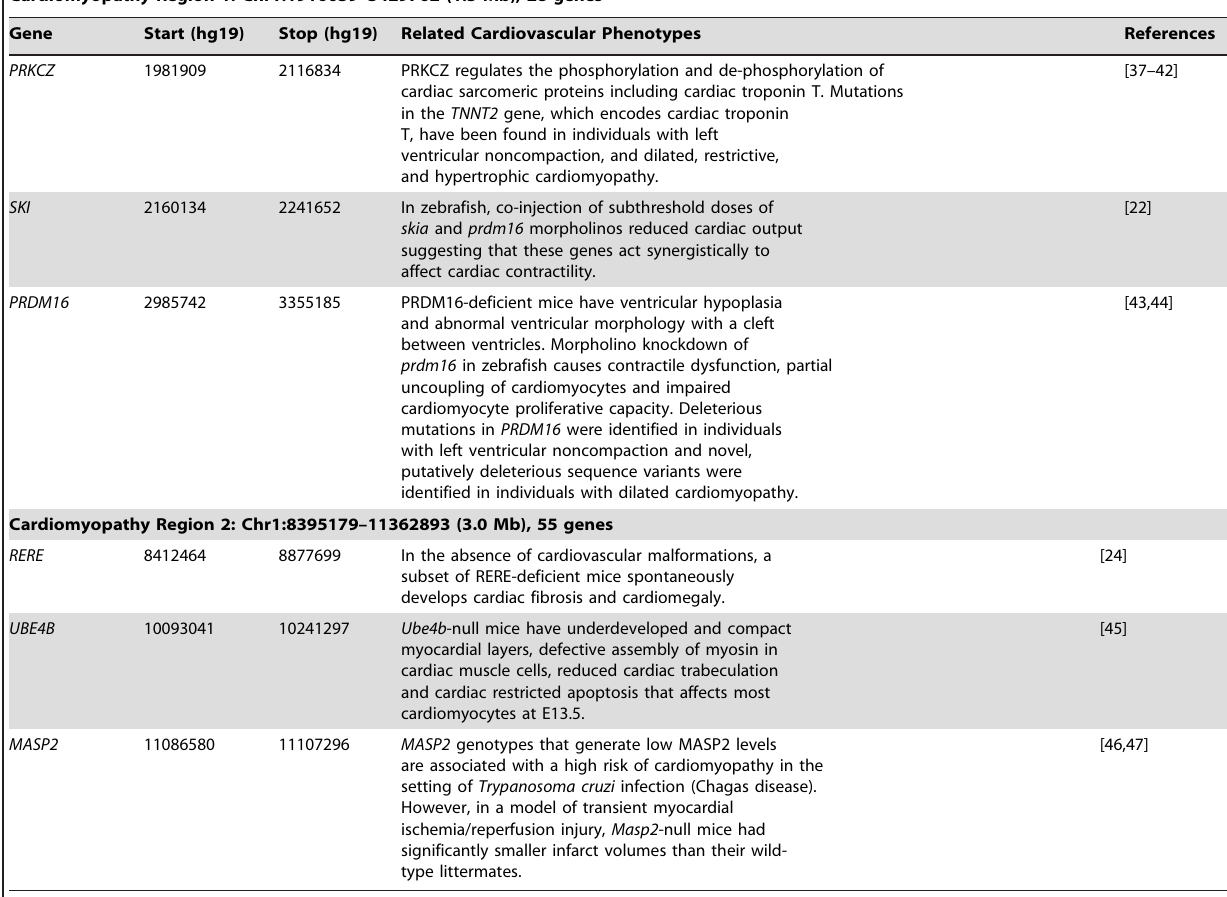
Table 8. Cardiac-related genes within cardiomyopathy critical